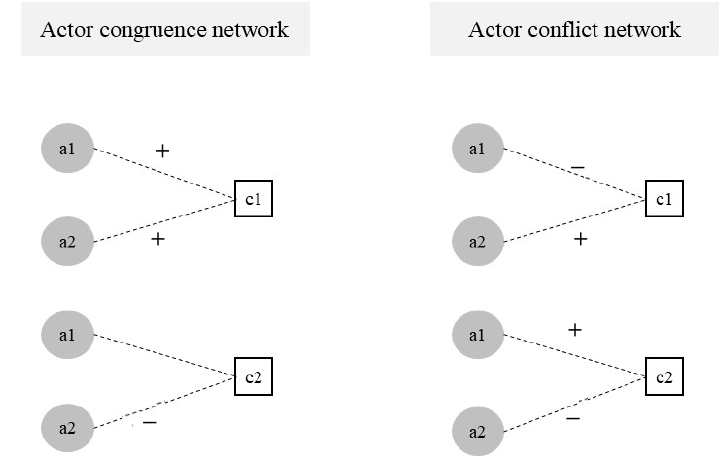
Figure 3. Two kinds of actor networks. The third step visualised the network using Python. Actor nodes were divided into five categories in the network (see Figures 4–6): national leaders, central government agency personnel (squares), local government agency personnel (circles), experts (upwards triangles), media (right triangles), and the public (inverted triangles). The Louvain algo- rithm automatically clustered nodes and assigned a colour to each node. The closer the colours were, the greater the probability that the nodes belonged to the same faction. The size of a node was determined by the degree of centrality.